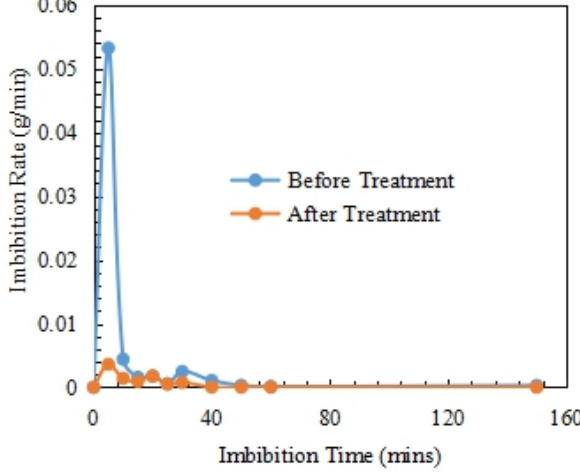
Figure 18. Air-brine imbibition rate curve [20].